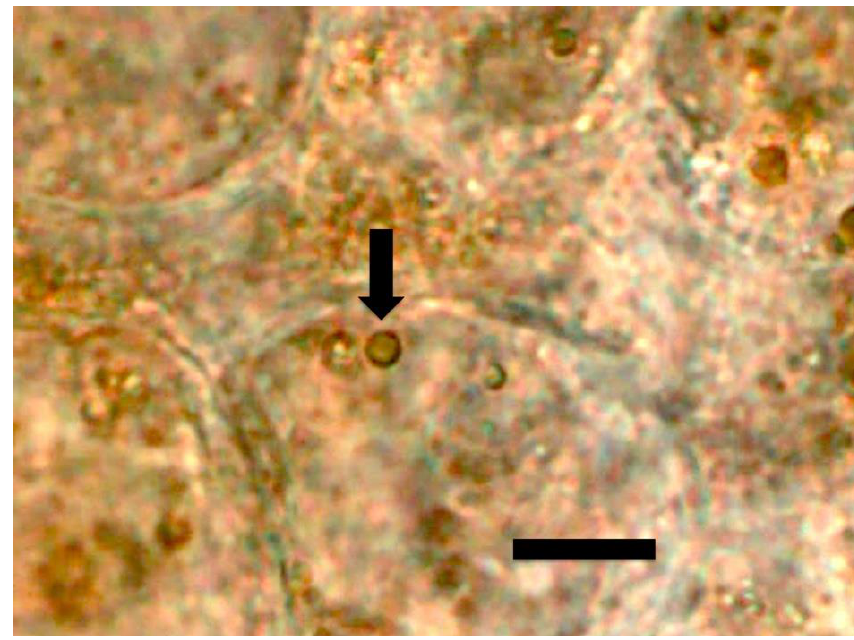
Figure 3. Tomato root cells at ‘root microbial entry zone’ stained with 1% ammonium molybdate to show ethylene (purple color) forming a ring around bacterial protoplasts (arrow) within root cell (bar = 5 µm).